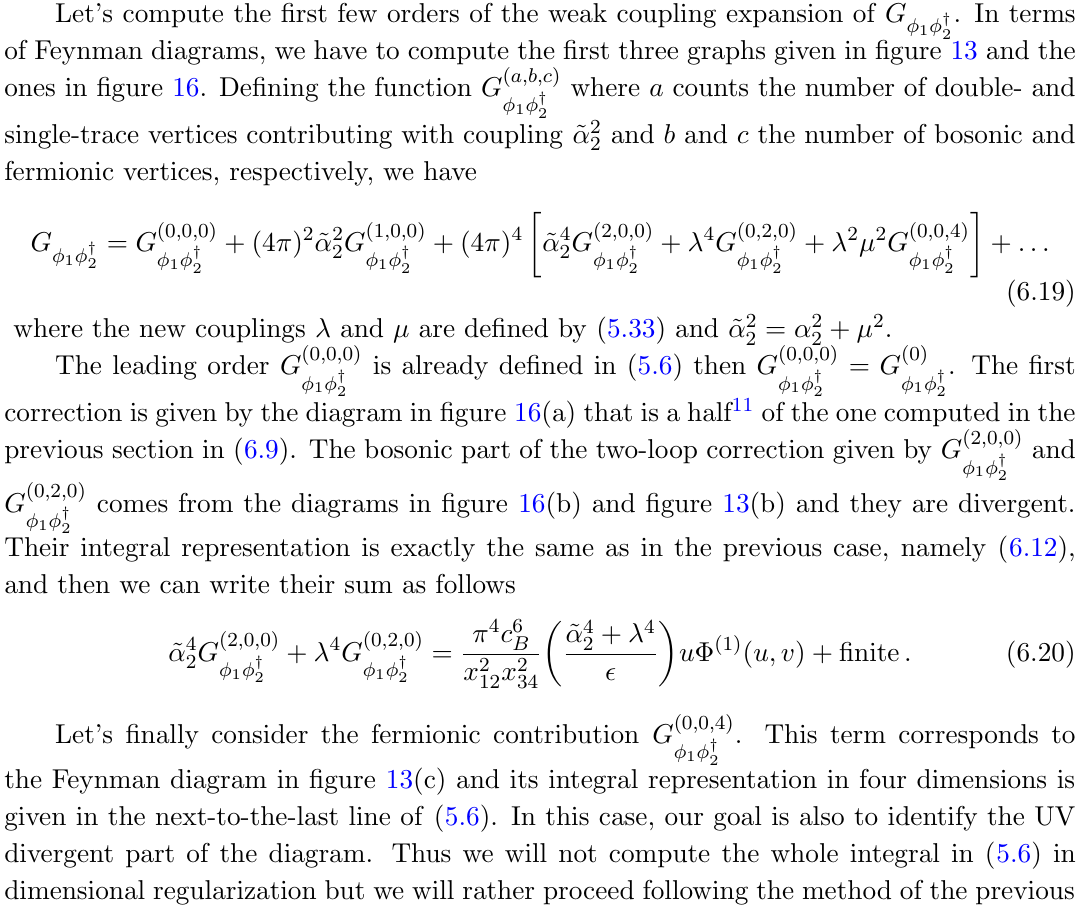
Figure 16 . First two contributions of the double- and single-trace vertices Tr[ (cid:30) 1 (cid:30) y Tr[ (cid:30) y (cid:30) y (cid:30) 1 (cid:30) 2 ] to the four-point functions G 1 2